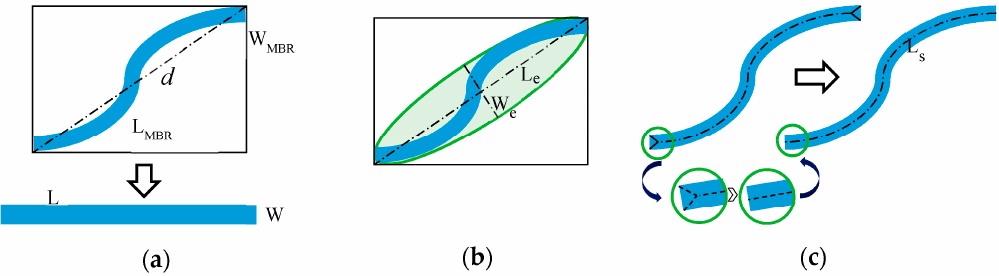
Figure 2. Comparison of the proposed skeleton-based object linearity index (SOLI) with LFI and LFIe. ( a ) LFI (figure is adapted from [13]); ( b ) LFIe (figure is adapted from [50]); ( c ) SOLI.